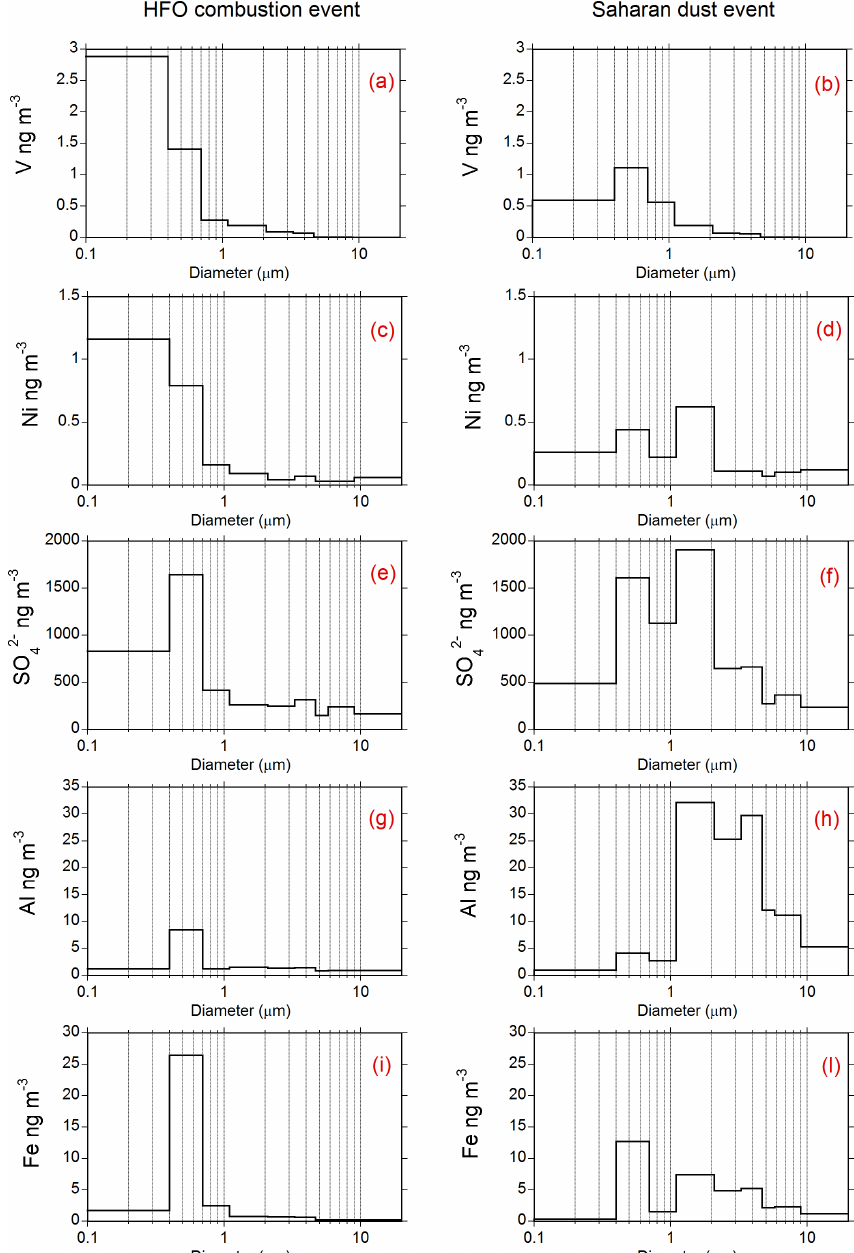
Fig. 8. V sol , Ni sol , SO 2 − , Al sol , Fe sol size distributions during a HFO combustion event (plots on the left, 20 June 2008) and during a 4 Saharan dust event (plot on the right, 17 May